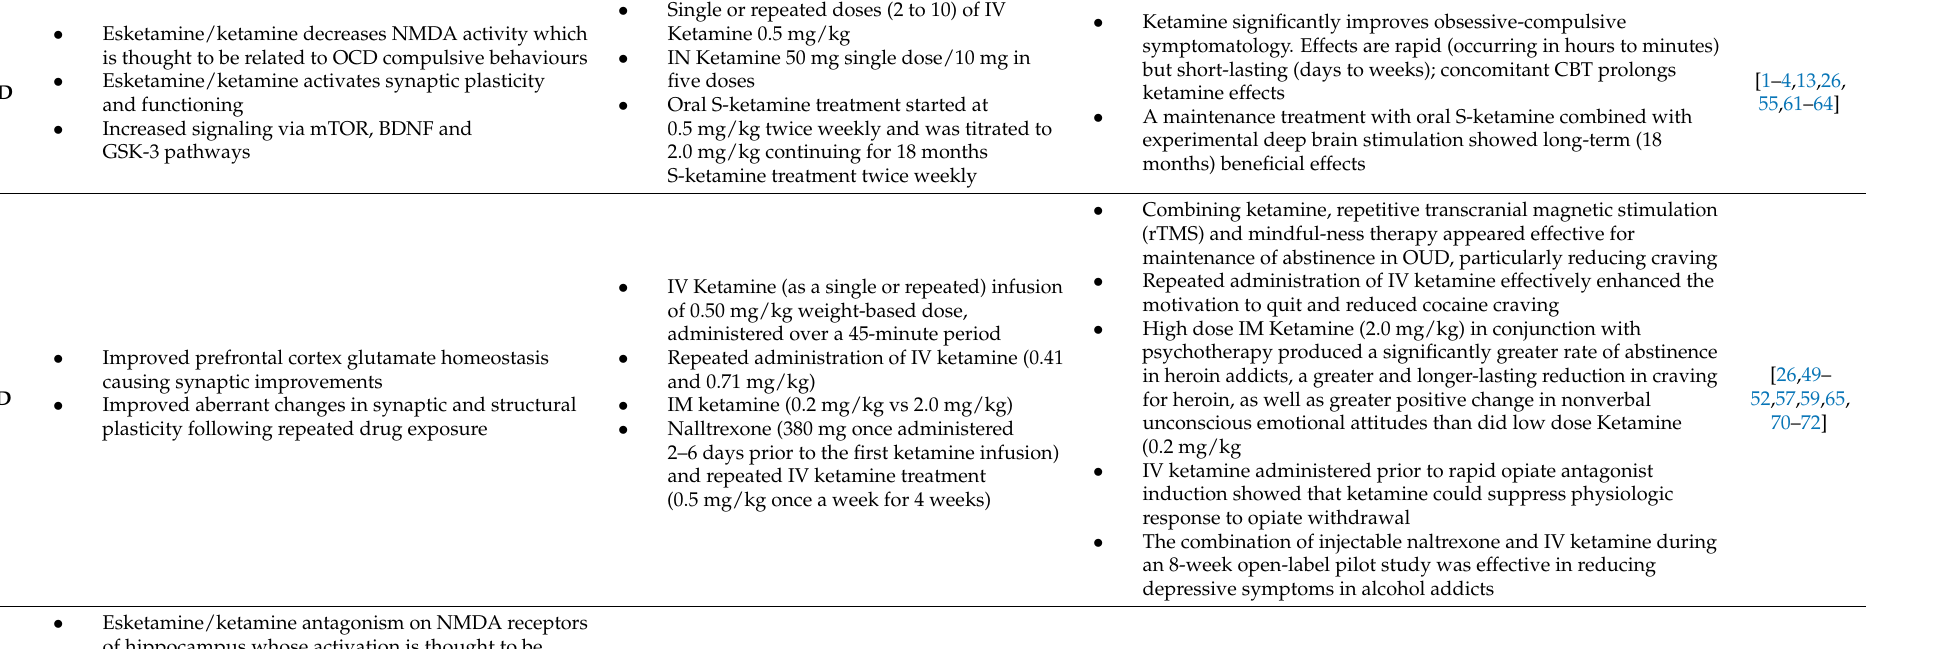
Table 2. Use ok ketamine and esketamine as a treatment for the obsessive-compulsive disorder (OCD), substance use disorders (SUD) and eating disorders (ED). Mechanism of Action Mediated by Ketamine/Esketamine Therapeutic Regimen Current Evidence